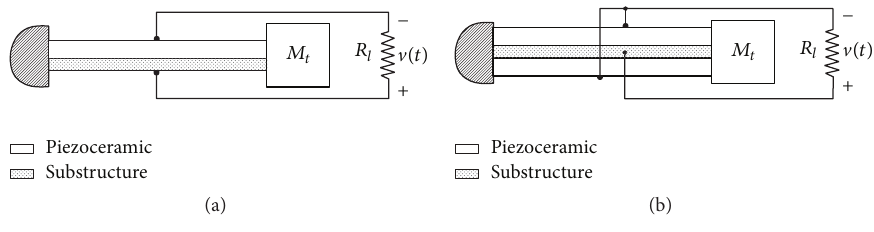
Figure 1: Cantilever piezoelectric energy configurations: (a) unimorph, (b) bimorph (parallel